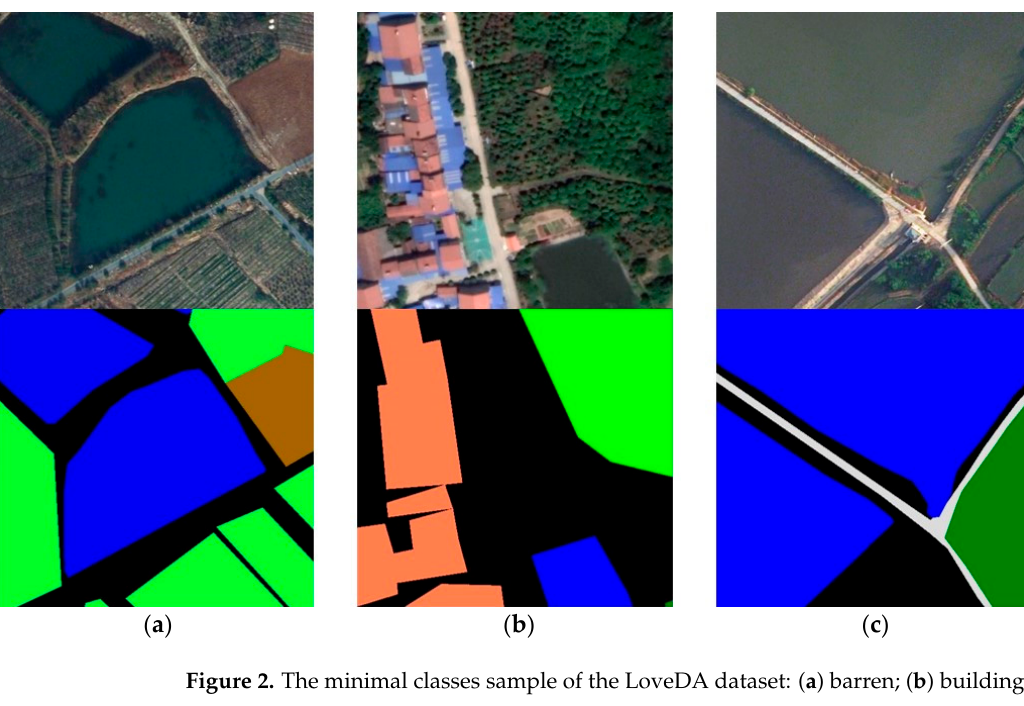
Figure 2. The minimal classes sample of the LoveDA dataset: ( a ) barren; ( b ) building; and ( c ) road.